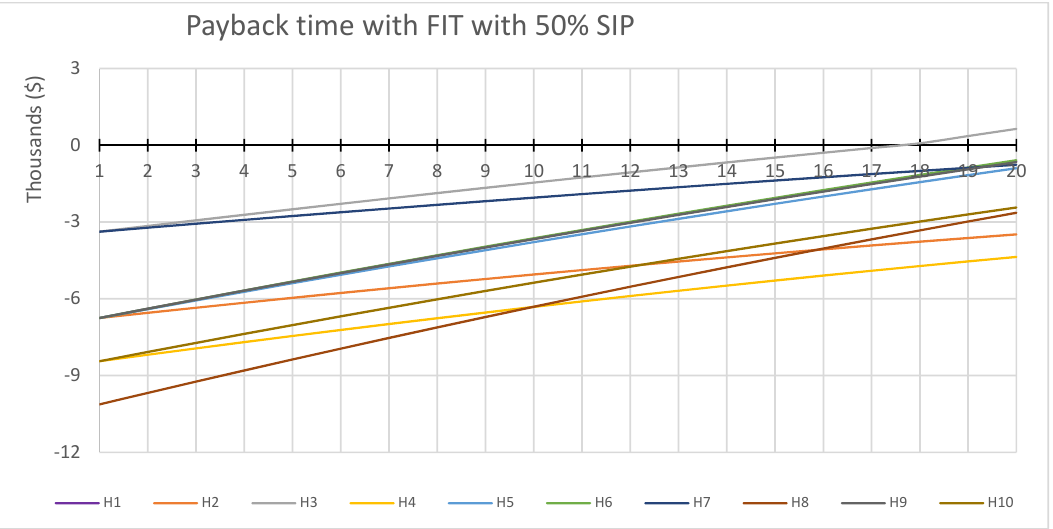
Figure 6. Economic model results demonstrating the payback time for the rooftop PV systems with FIT with 50% SIP for houses H1:H10.